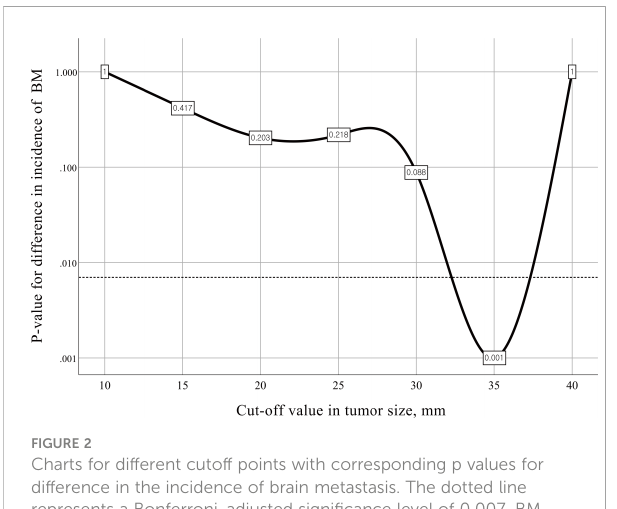
FIGURE 3 Incidence of brain metastasis according to tumor